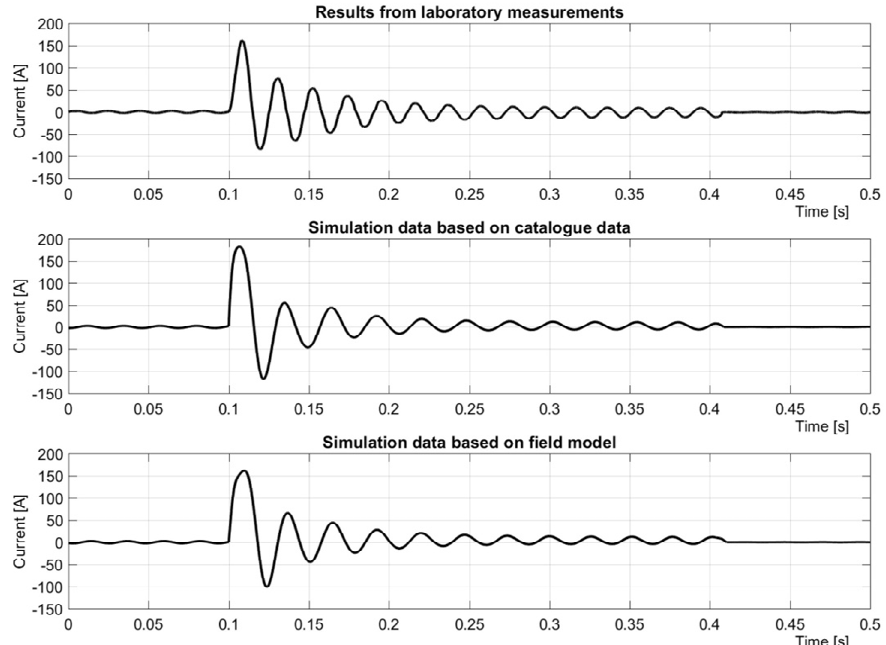
Figure 7. Waveform of the short-circuit current phase for L 1 (first phase of generator) phase of the synchronous generator for a short-circuit case modeled after the fifth line section.